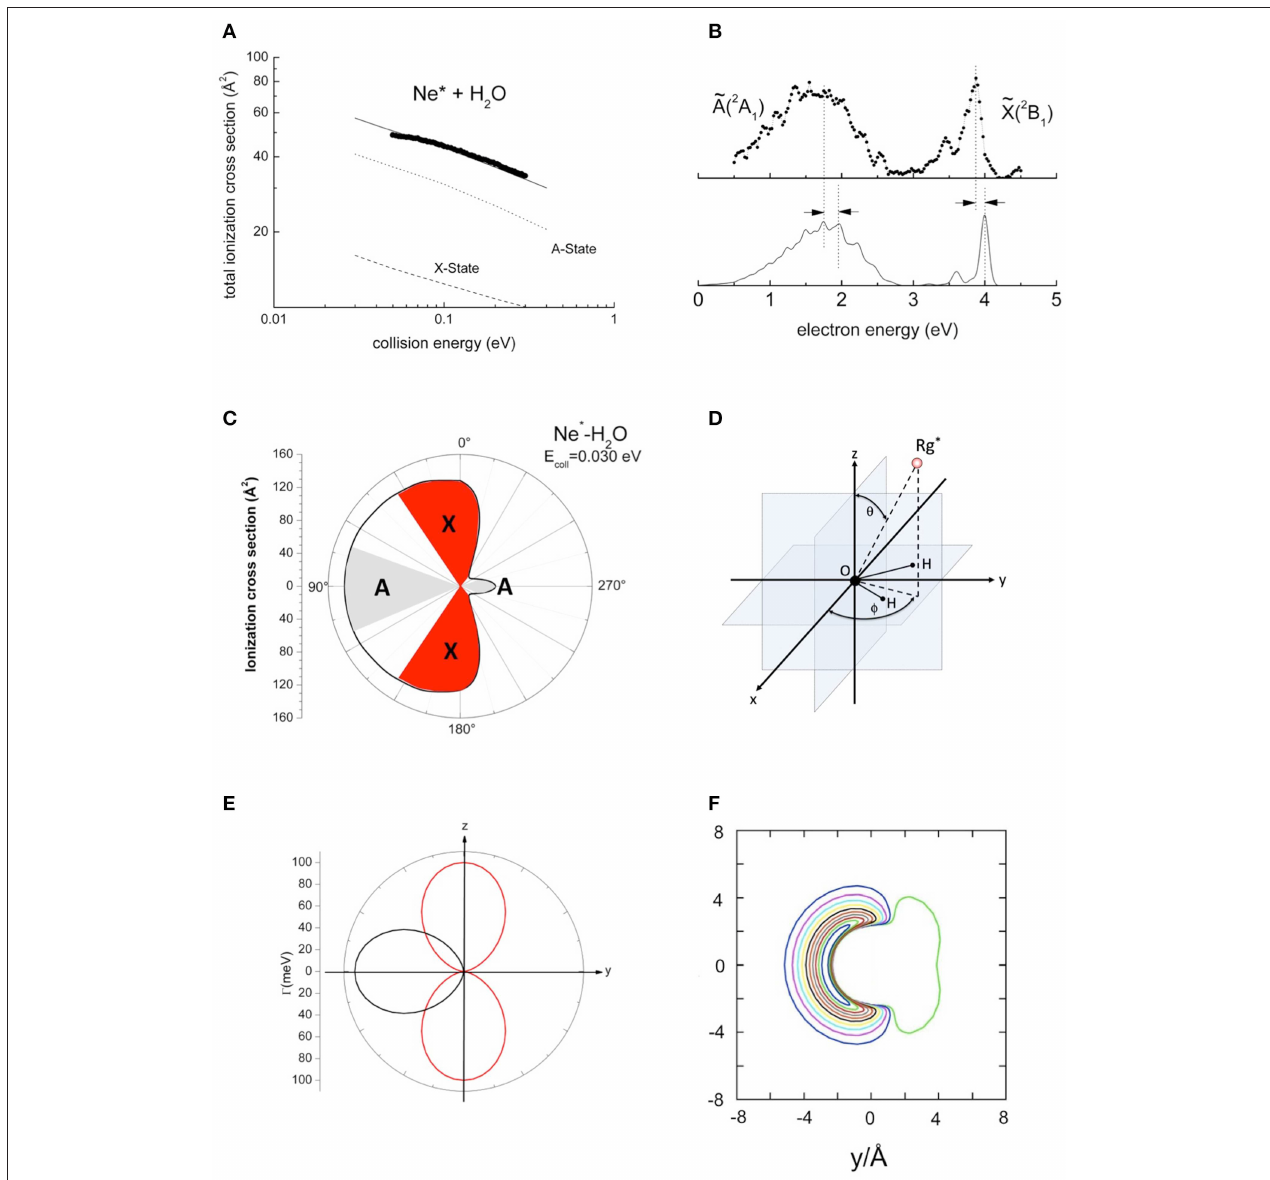
FIGURE 2 | The results about the ionization of the water molecule by metastable Ne * ( 3 P 2,0 ). (A) Total ionization cross sections where the contribution for the two ionic state are separated. (B) Penning ionization electron spectrum where the shifts with respect the nominal expected positions of the peaks are also indicated. (C) A polar map of the ionization efficiency in a plane perpendicular to the molecule. (D) The polar coordinate framework used to analyze the experimental data. (E) The polar plot of the imaginary component of the optical potential for the production of A (black) and X (red) states of the H 2 O + product ion. (F) A contour map of the real part of the optical potential on the molecular plane (for details see Falcinelli et al.,